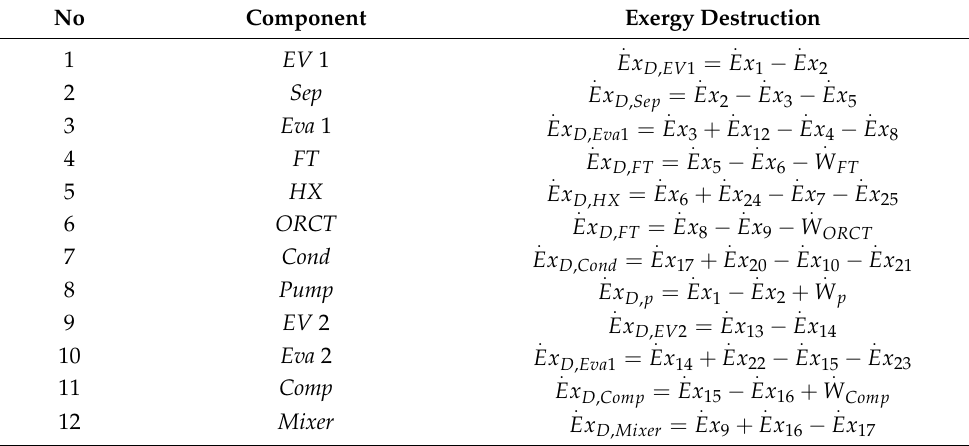
Table 3. The exergy destruction rate equation of all